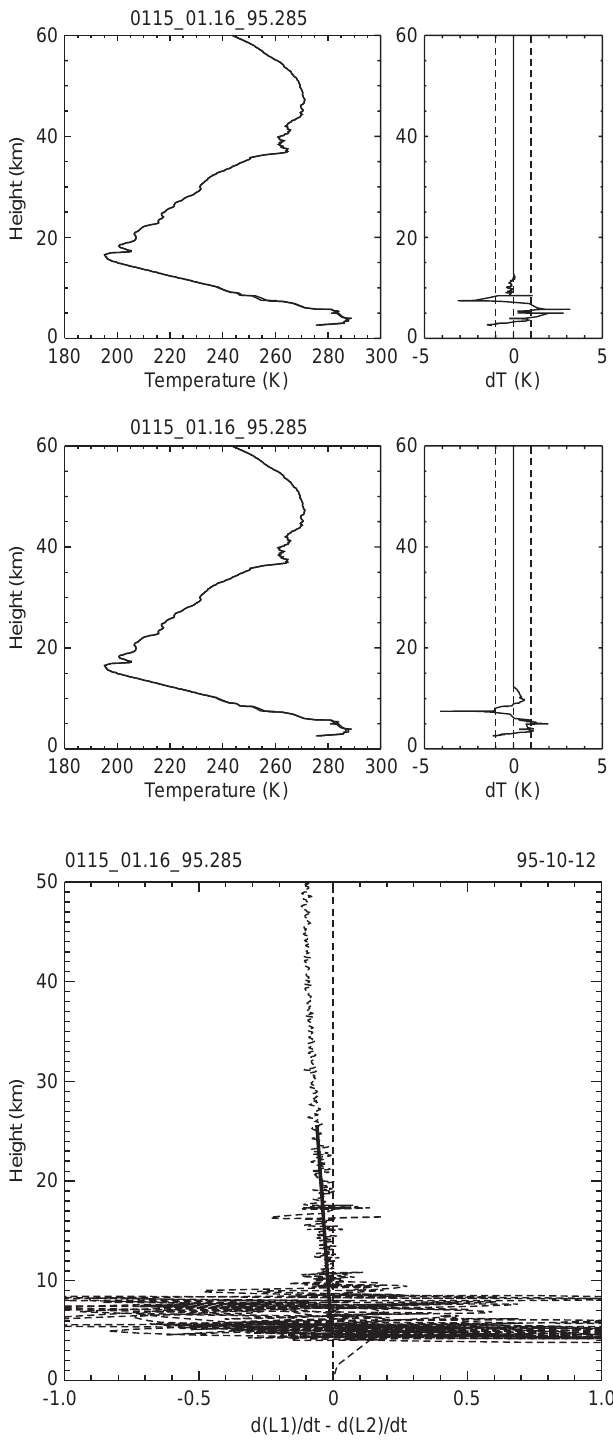
b Fig. 3. Illustration of reliable ionospheric correction in the tropo- sphere by means of extrapolating ionospheric Doppler shift linearly downwards to below 12.5 km height. The upper four panels show temperature retrieval results and temperature di(cid:128)erences (d T ), respectively (di(cid:128)erence relative to direct L 1– L 2 combination for the entire profile). The reliable method ( top panels ) is illustrated and a straightforward method, which simply uses L 1 Doppler below 12.5 km height ( middle panels ). The bottom panel shows the ionospheric Doppler in terms of the L 1- L 2 Doppler di(cid:128)erence ( dotted profile ), and indicates the Doppler extrapolation applied ( solid line ). The primary data are from GPS/MET occultation event 115 on October 12, 1995, 15:12 UT, located at 1.1 (cid:176) S and 51.9 (cid:176) W